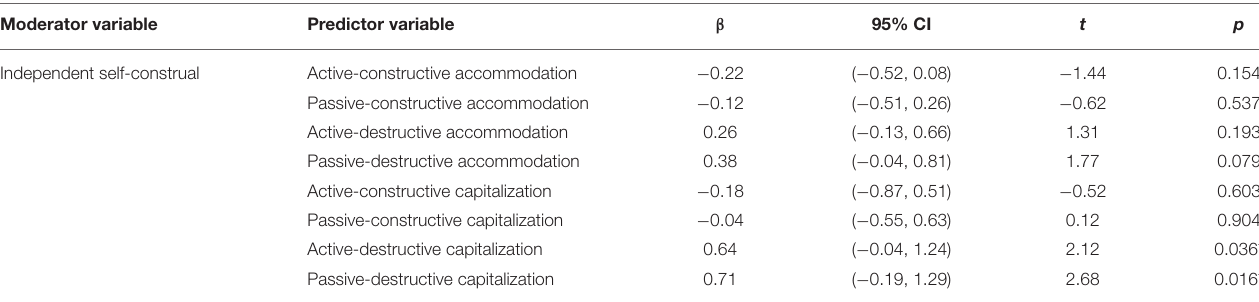
TABLE 8 | Moderation of independent self-construal for accommodation and capitalization reponses and relationship satisfaction. Moderator variable Predictor variable Independent